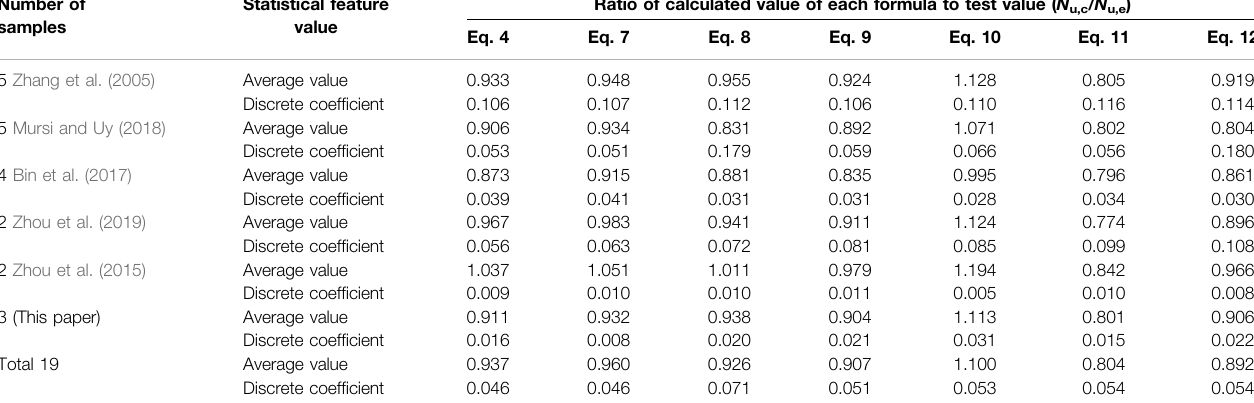
Statistical feature value